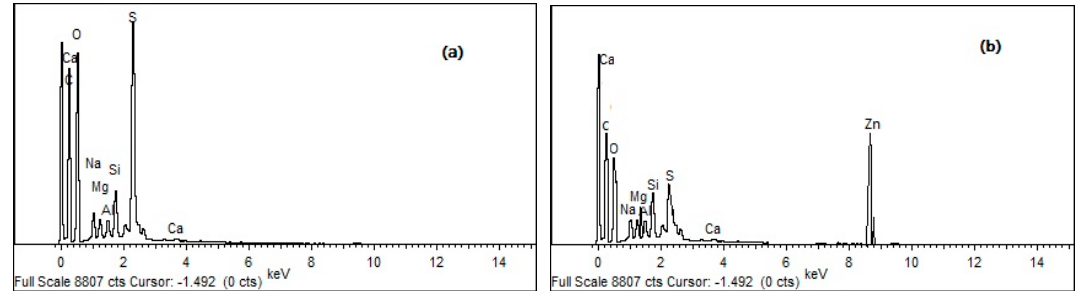
Figure 10. EDX (energy dispersive X-ray spectroscopy) analysis of Ln@AC nanocomposite ( a ) before and ( b ) after adsorption of Zn(II).